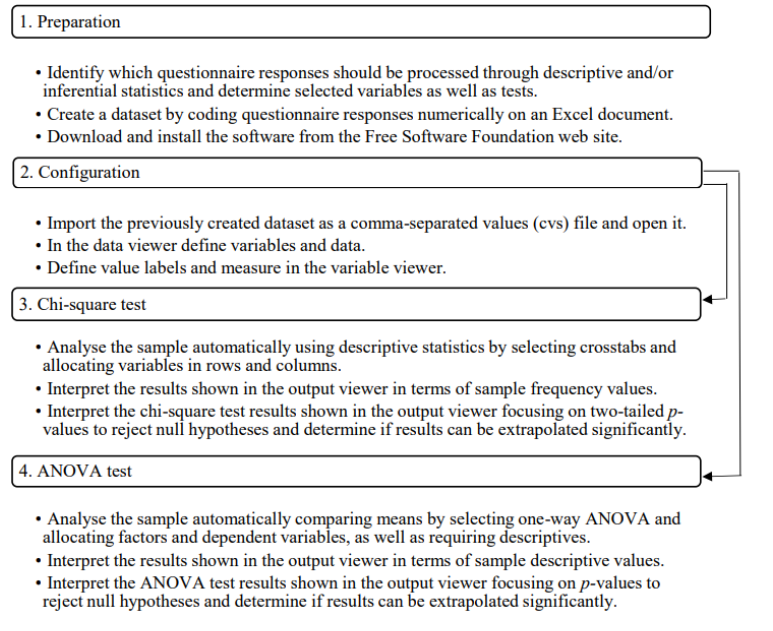
Figure 1: Process for PSPP